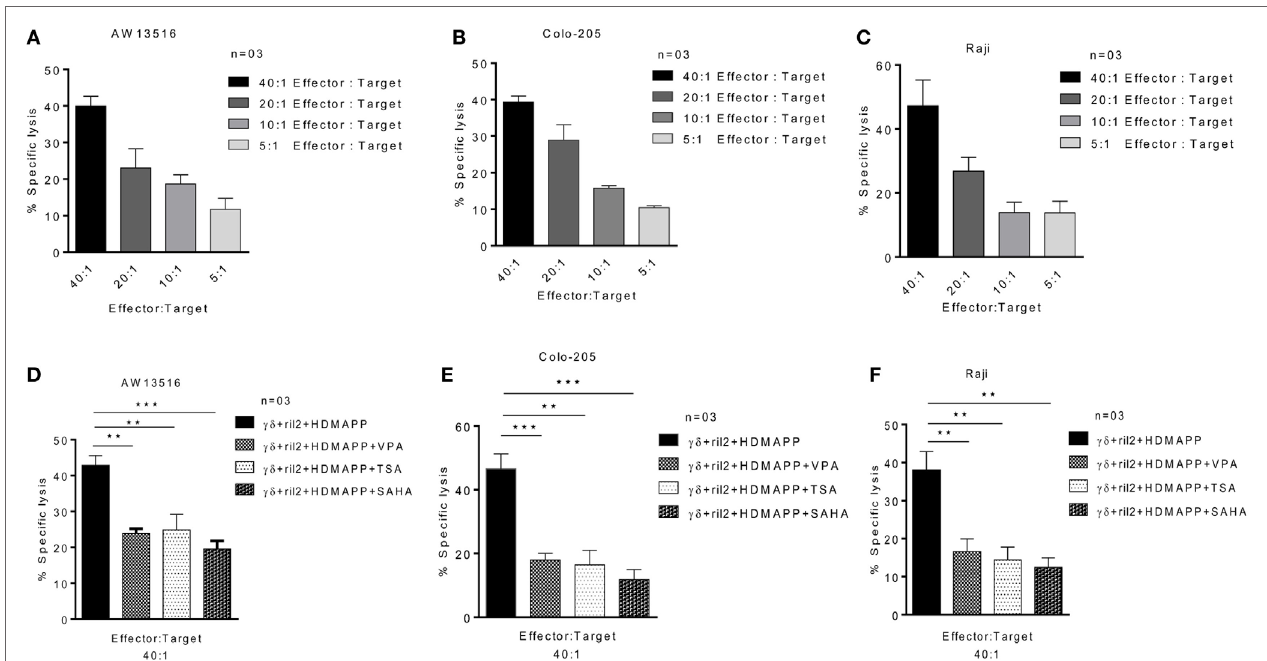
FigUre 6 | Histone deacetylases inhibitors decrease the cytotoxic effector functions of γδ T cells. Cytotoxic effector function of γδ T cells was assessed against three tumor cell lines (a) AW13516, (B) COLO205, and (c) Raji. Zoledronate-treated tumor targets were cocultured with γδ T cells for 4 h and cytotoxicity was assessed by lactate dehydrogenase (LDH) assay. The results indicated are mean percent specific lysis at different effector:target ratio. Data are representative of three individual experiments. Cytotoxic potential of γδ T cells activated with HDMAPP in the presence of rIL-2 with or without treatment with sodium valproate (2 mM), suberoylanilidehydroxamic acid (1 µM), and Trichostatin-A (100 nM) was assessed against three zoledronate-treated tumor targets AW13516 (D) , COLO-205 (e) , and Raji (F) by LDH cytotoxicity assay. The results indicated are percent specific lysis at the effector to target ratio of 40:1 where ** p < 0.005 and *** p < 0.0005 when compared with γδ T cells activated with HDMAPP in the presence of rIL-2 ( n =